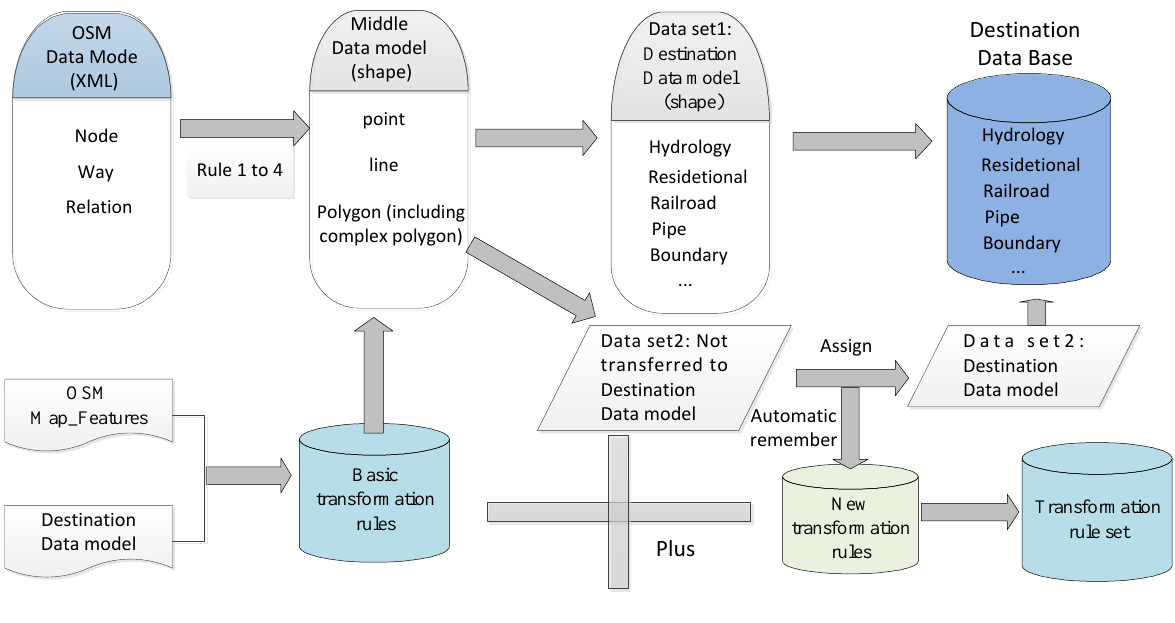
Figure 2. The model transformation